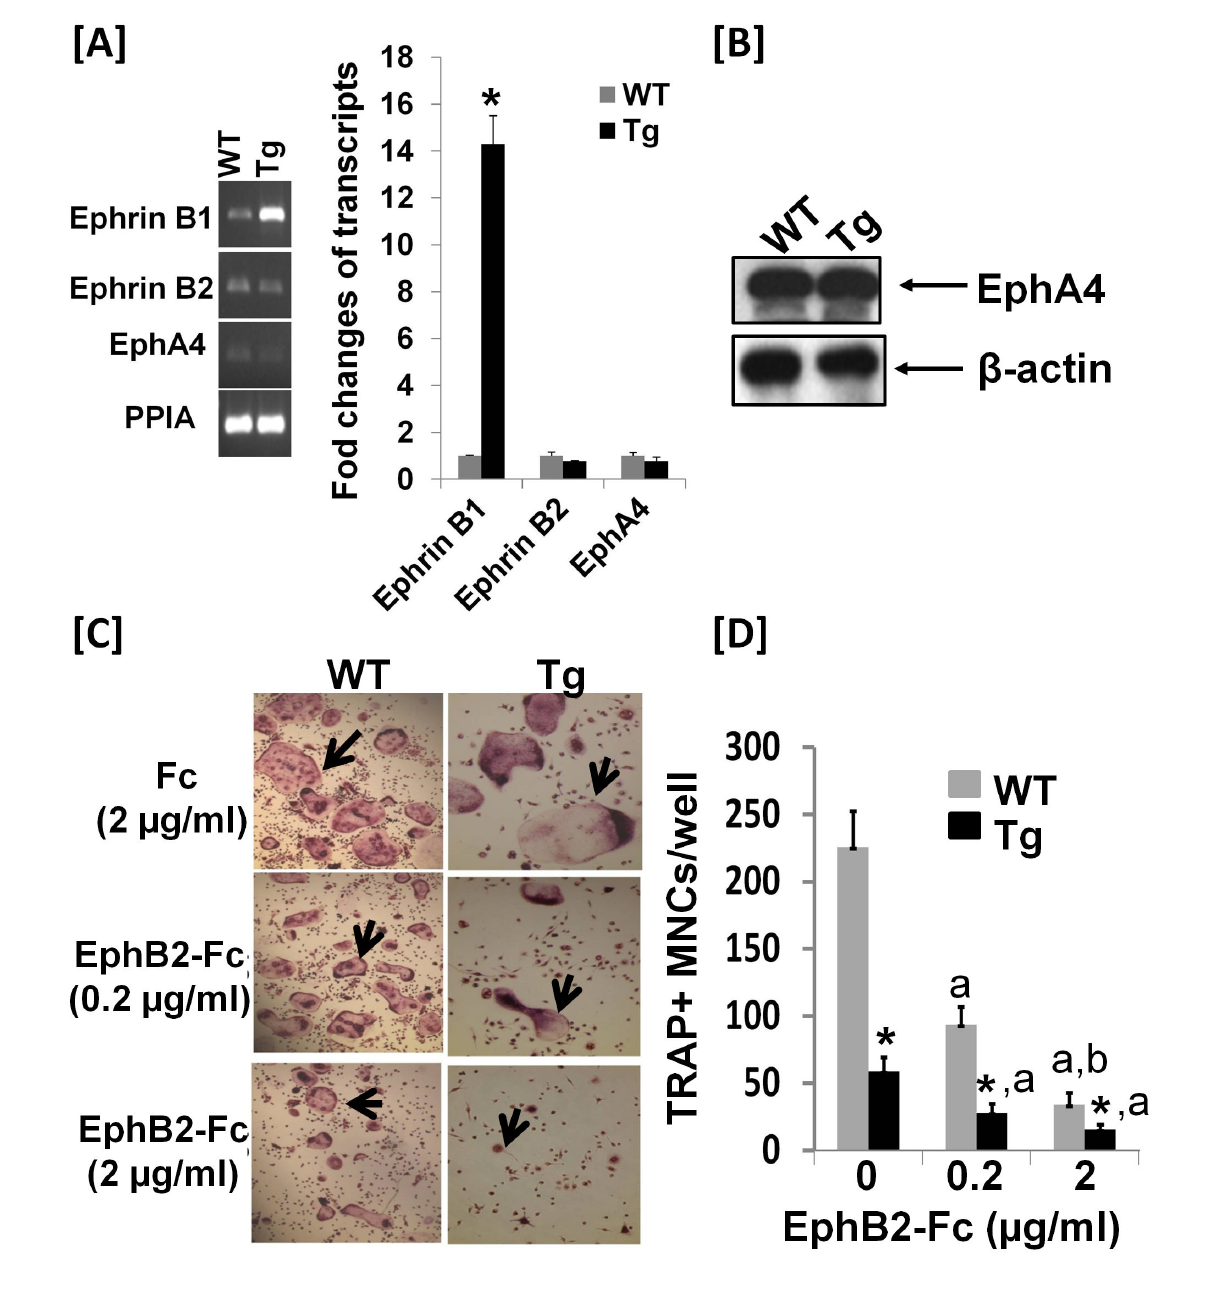
Figure 6. Overexpression of ephrin B1 in monocytes inhibits osteoclast differentiation. [A] Transcripts of ephrin B1, ephrin B2 and EphA4 in multinucleated cells (MNCs) derived from the spleen of WT and Tg mice detected by real-time PCR (N = 3 males). [B] Western blots show EphA4 expression in MNCs derived from one pair of WT and Tg male littermates. [C] Images of osteoclast differentiation. Monocytes derived from the spleen of WT and Tg mice were differentiated in the presence of M-CSF and RANKL, and treated with EphB2-Fc or control Fc for 8 days, followed by TRAP staining. The arrows indicate MNCs. [D] Quantitative data of MNC formation. Osteoclast precursors were pooled from 3 pairs of WT and Tg littermate males and seeded in 48-well plates in the presence of M-CSF and RANKL for differentiation. Data are the means ± SEM for N = 10 wells. Experiments were repeated for 3 times and similar results were obtained. A star represents statistical significance (P < 0.01) when compared to WT littermate controls. “a” indicates statistical significance (P < 0.01) when compared to vehicle control of the same cells. “b” indicates statistical significance (P < 0.01) when compared to 0.2 μg/ml treatment of the same cells. doi: 10.1371/journal.pone.0069051.g006 PLOS ONE |